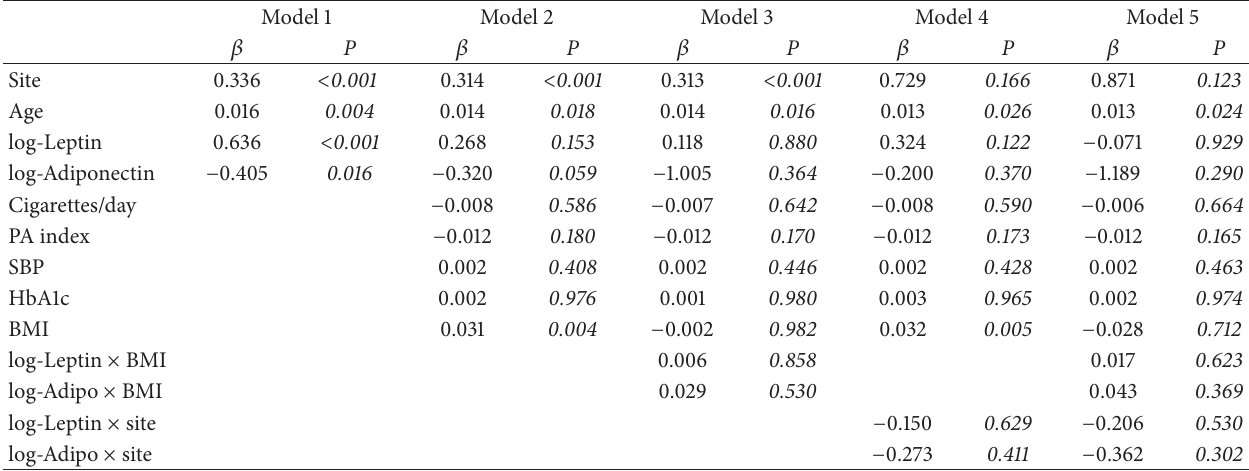
Table 5: Relations of serum log-leptin and log-adiponectin to log-CRP in